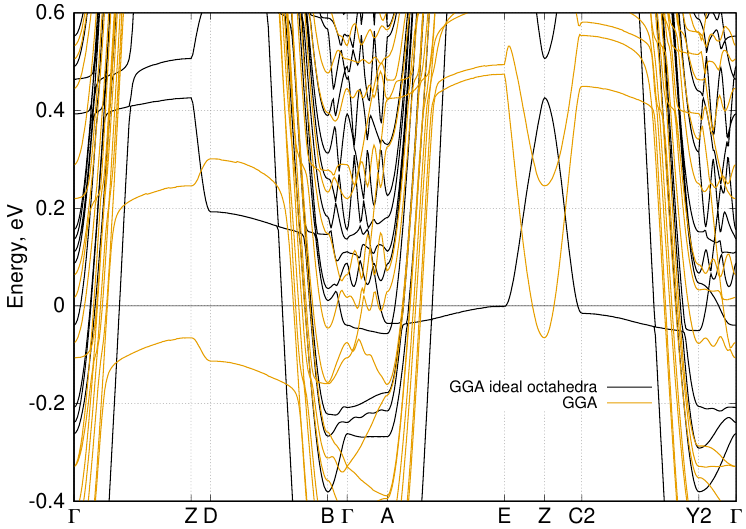
Figure 6. Comparison of the DFT-calculated band structure for the real W 20 O 58 without SOC (orange) and W 20 O 58 with the ideal octahedra (black) [28]. Zero corresponds to the Fermi